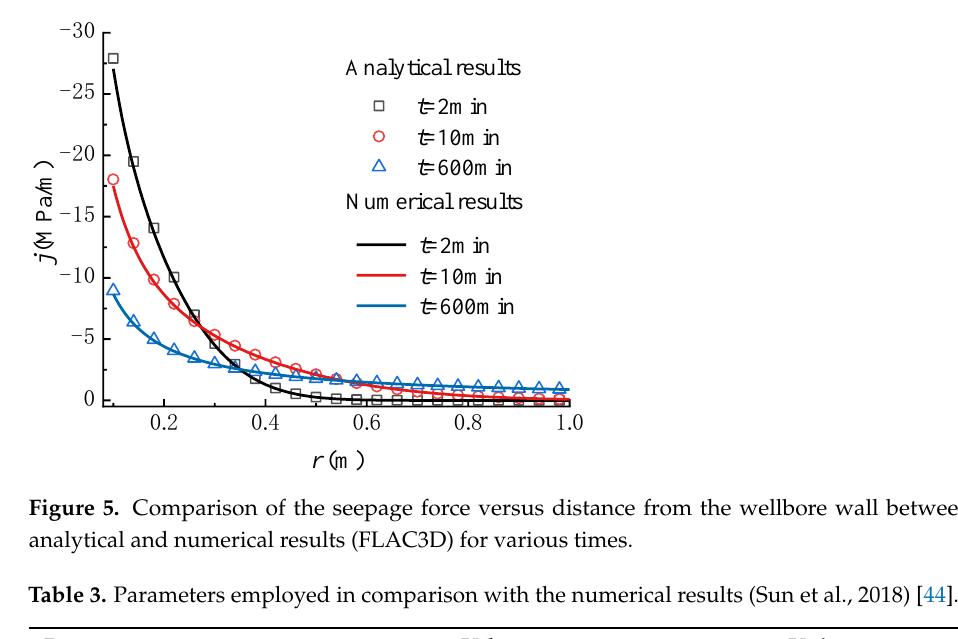
alytical and the numerical results (FLAC3D) for various times.